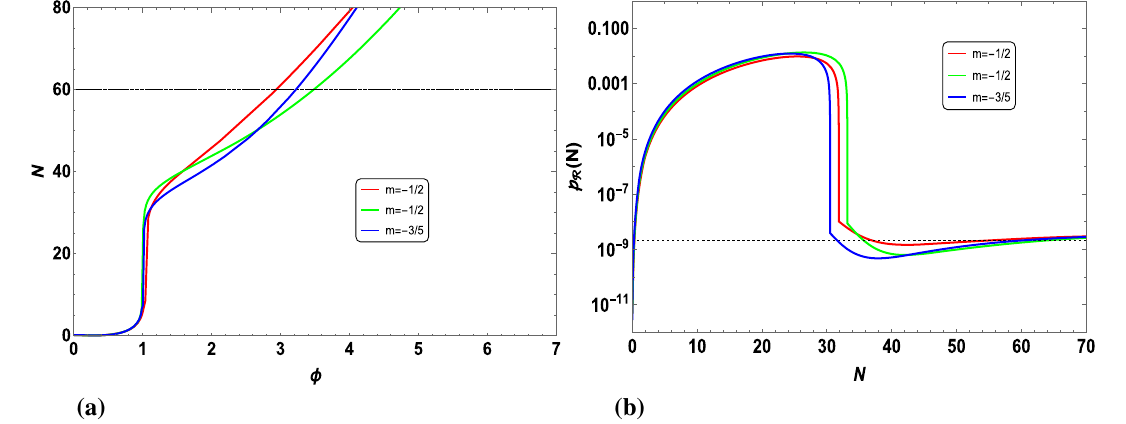
Fig. 2 Left panel: three different colors correspond to three different valuesofpotentialparameter x .Redcolorcorrespondsto x = 8 . 4,green is for x = 6 . 0 and blue stands for x = 8 . 6. The number of e-folds ( N ) as a function of the scalar field ( φ ). The dotted black line corresponds to the N = 60. Right panel: the scalar power spectrum as a func- tion of the Number of e-folds ( N ). Three different colors correspond to three different values of potential parameter x . Red color corresponds